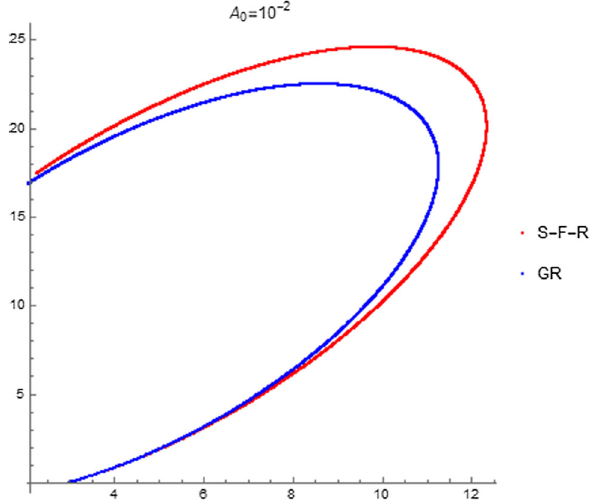
Fig. 4 This is a polar graph of the timelike paths that we find using our theoretical SFR (red curve) model in comparison to the geodesics of GR (blue line) for E = 0 . 98, L = 1, r 0 = 3 and ( a , b , c ) = ( 1 , 10 , 10 ) horizon faster than the blue ellipse (GR). We remark that in the path equations (69) the right hand side is non-zero and this term acts as a small extra force that influences the paths in the gravitational field. This correction increases or decreases the effects of gravity depending on the sign of the term. In the two figures (Figs. 3, 4) we have taken a = 1, b = 10 and c = 10 in (67). In this case, we can see that the red line (SFR model) takes higher values than the blue line (GR) and it requires more time to reach the Schwarzschild radius. In ˜ A 0 , a , b , c ) control the deviation our case, the parameters ( of the SFR model from General Relativity. In particular, the values of ( a , b , c ) can give higher or lower results compared to